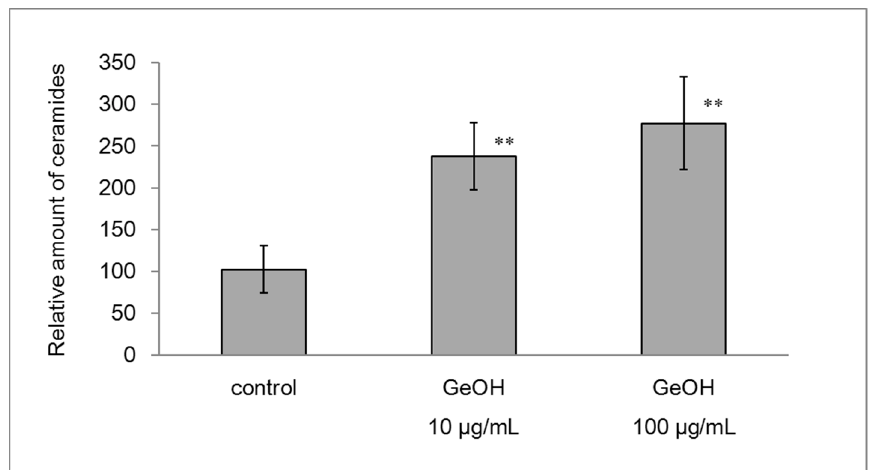
Figure 6. Effects of GeOH on ceramides levels in the epidermis model. The levels of ceramides (1 and 2) in the epidermis model cultured for 3 days with or without GeOH were measured by silica gel thin-layer chromatography. The results are presented as the mean ± S.D. of three experiments. ** p < 0.01 vs. control.